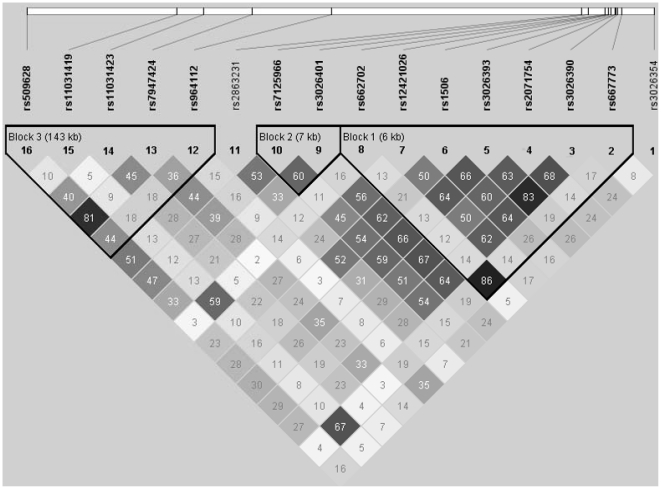
Linkage disequilibrium (LD) pattern across the 16 single nucleotide polymorphisms under study.LD measures are expressed as r2 in Group 1 subjects (cases and controls combined). The LD blocks are defined using the solid spine of LD algorithm of Haploview.